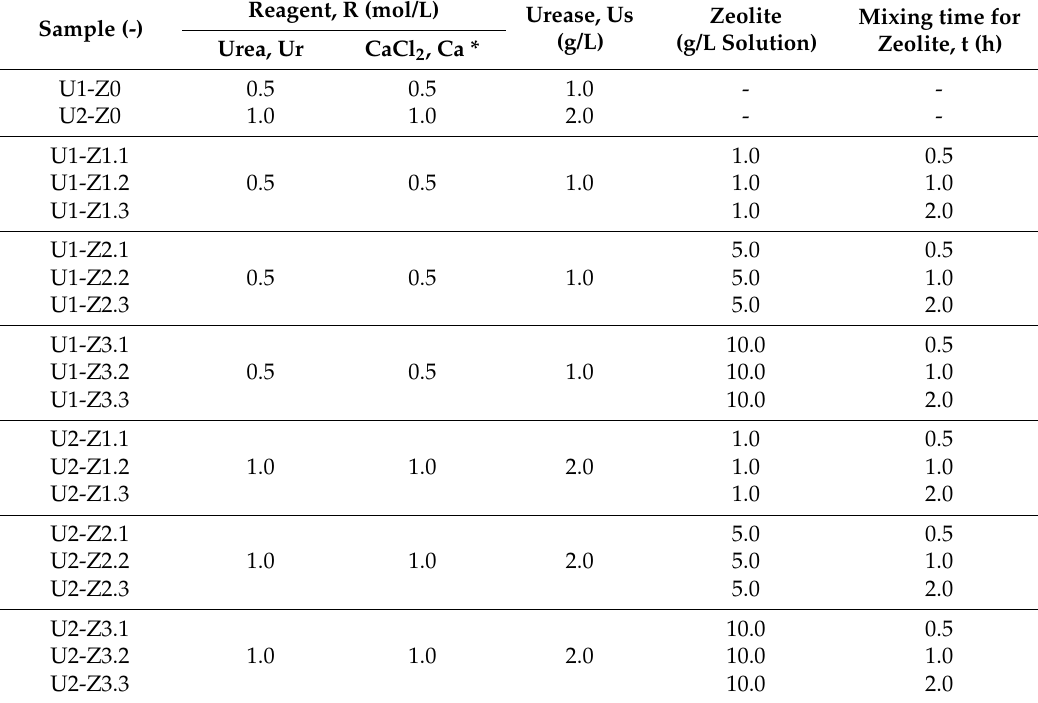
Table 3. Experimental conditions for NH-forms measurement and precipitation